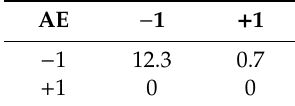
Table 6. Analysis of the e ff ect of interaction AE on the retained austenite. It can be seen that placing both factors at their − 1 levels leads to a greater increase in retained austenite.